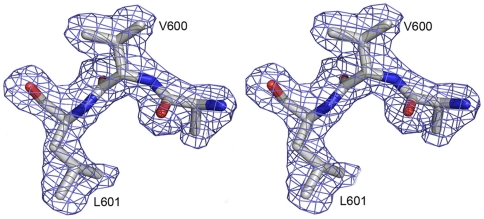
Stereo view of the electron density map.Simulated annealing Fo-Fc omit map of the C-terminal region of E2s, which is crucial for the dimerization. Residues Val600, Leu601 and all atoms within 2.0 Å were omitted prior to refinement. The map contoured at a level of 3σ. This figure was prepared using PyMol [34].